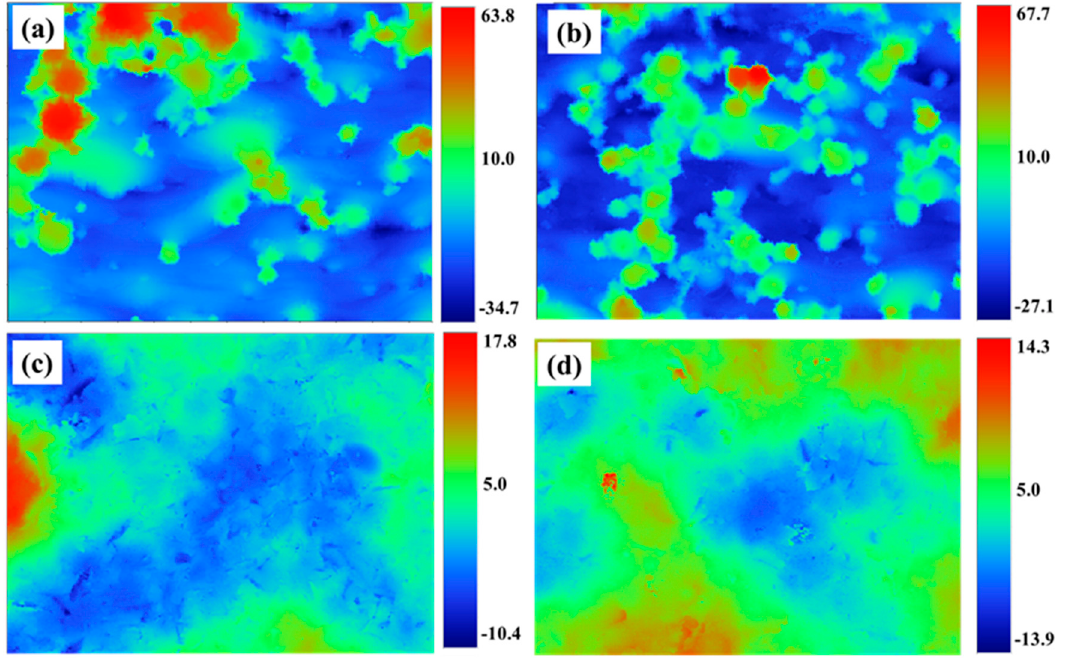
Figure 7. Surface roughness of; ( a ) AB, ( b ) HT, ( c ) SP, and ( d ) HTSP samples on the surface in the XZ plane.